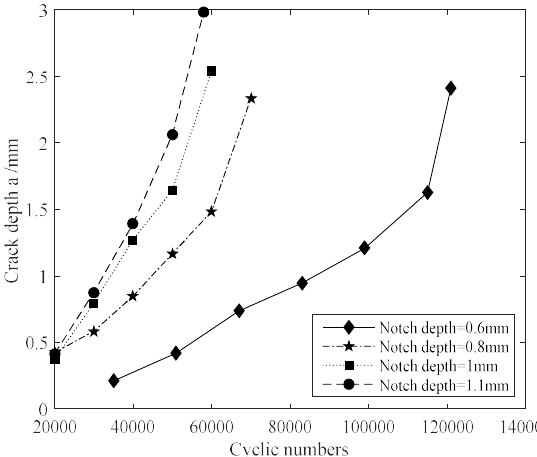
Figure 18. Variation of crack depth with cyclic numbers.